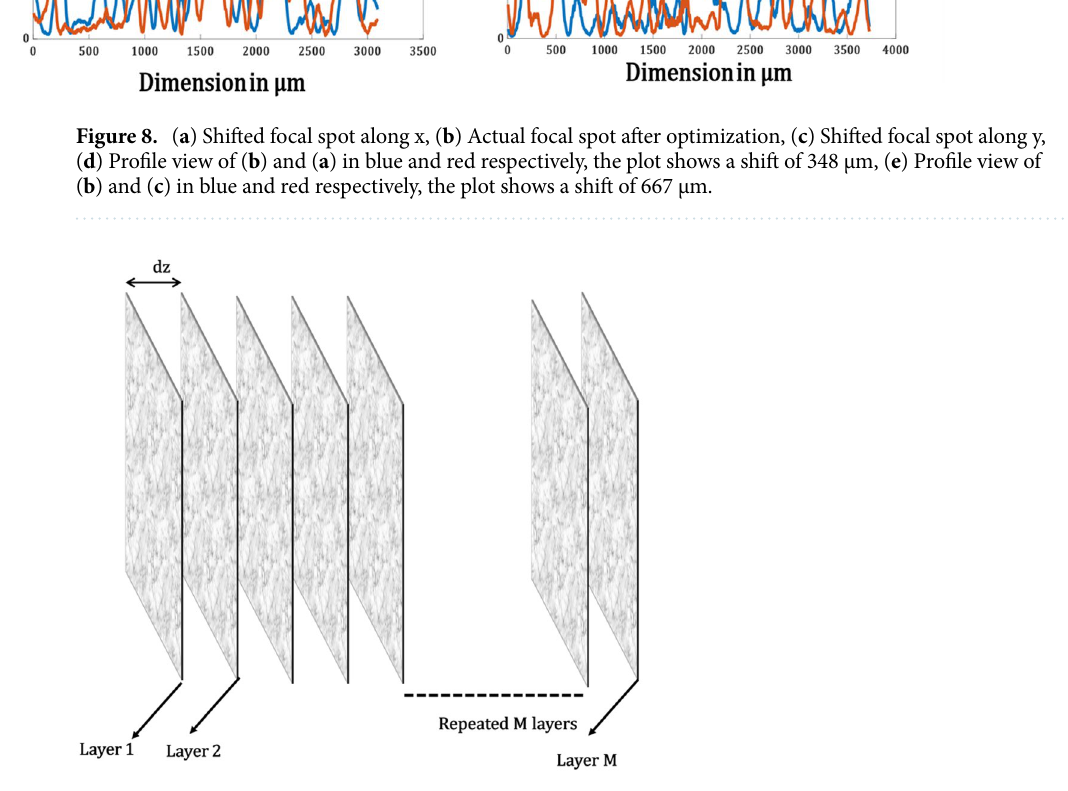
Figure 9. Modelling a thick scattering medium as a stack of phase plates followed by a small frees-pace